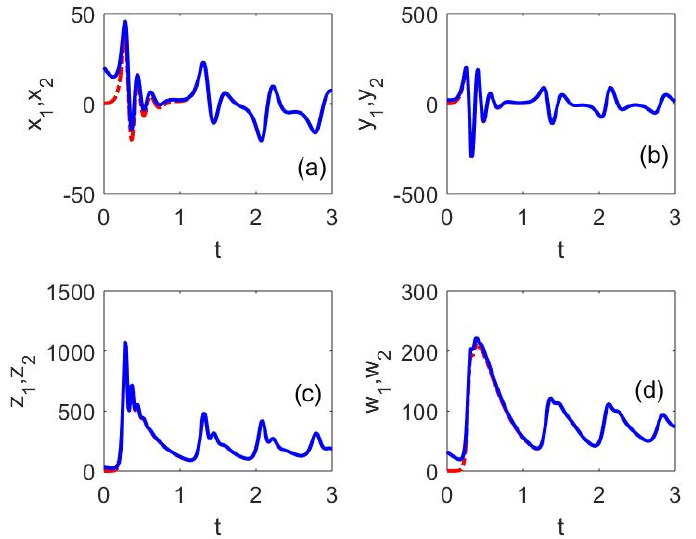
Figure 10. Time series of the drive supply chain system (12) (blue line) and the response supply chain system (13) (red dot line) when q = 0.75, and d = 0.7.